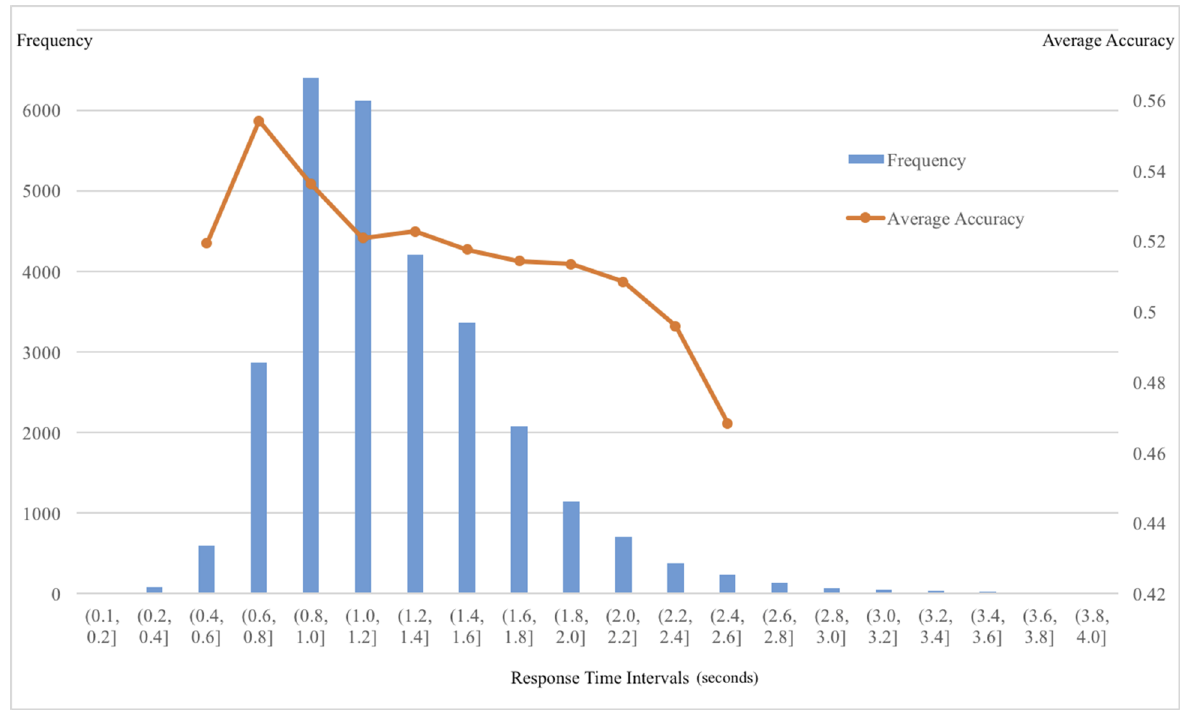
Fig 3. Distribution of response times and average agreement. The histogramrepresentsthe distributionof responsetimes over all trials (n = 28540)across all participants, candidatepairs, and traits, excludingmissing data, data for recognized candidates, and seven trials with responsetimes less than 100 milliseconds. The line represents the averageagreement over trials with responsetimes within the given interval, omitting those for response-time intervalswith less than 200 trials.